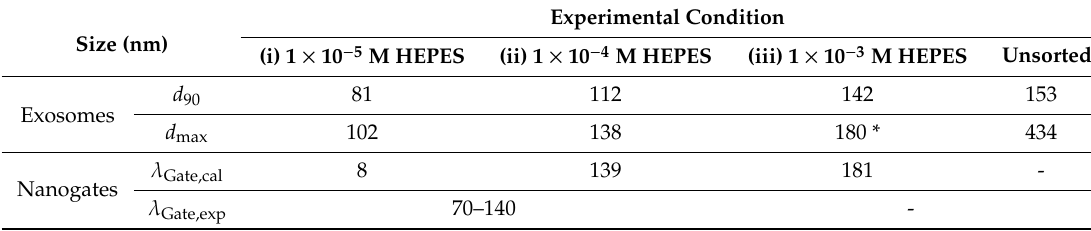
Table 2. d 90 and d max values in the collected exosomes, and λ Gate,cal and λ Gate,exp values under each condition.